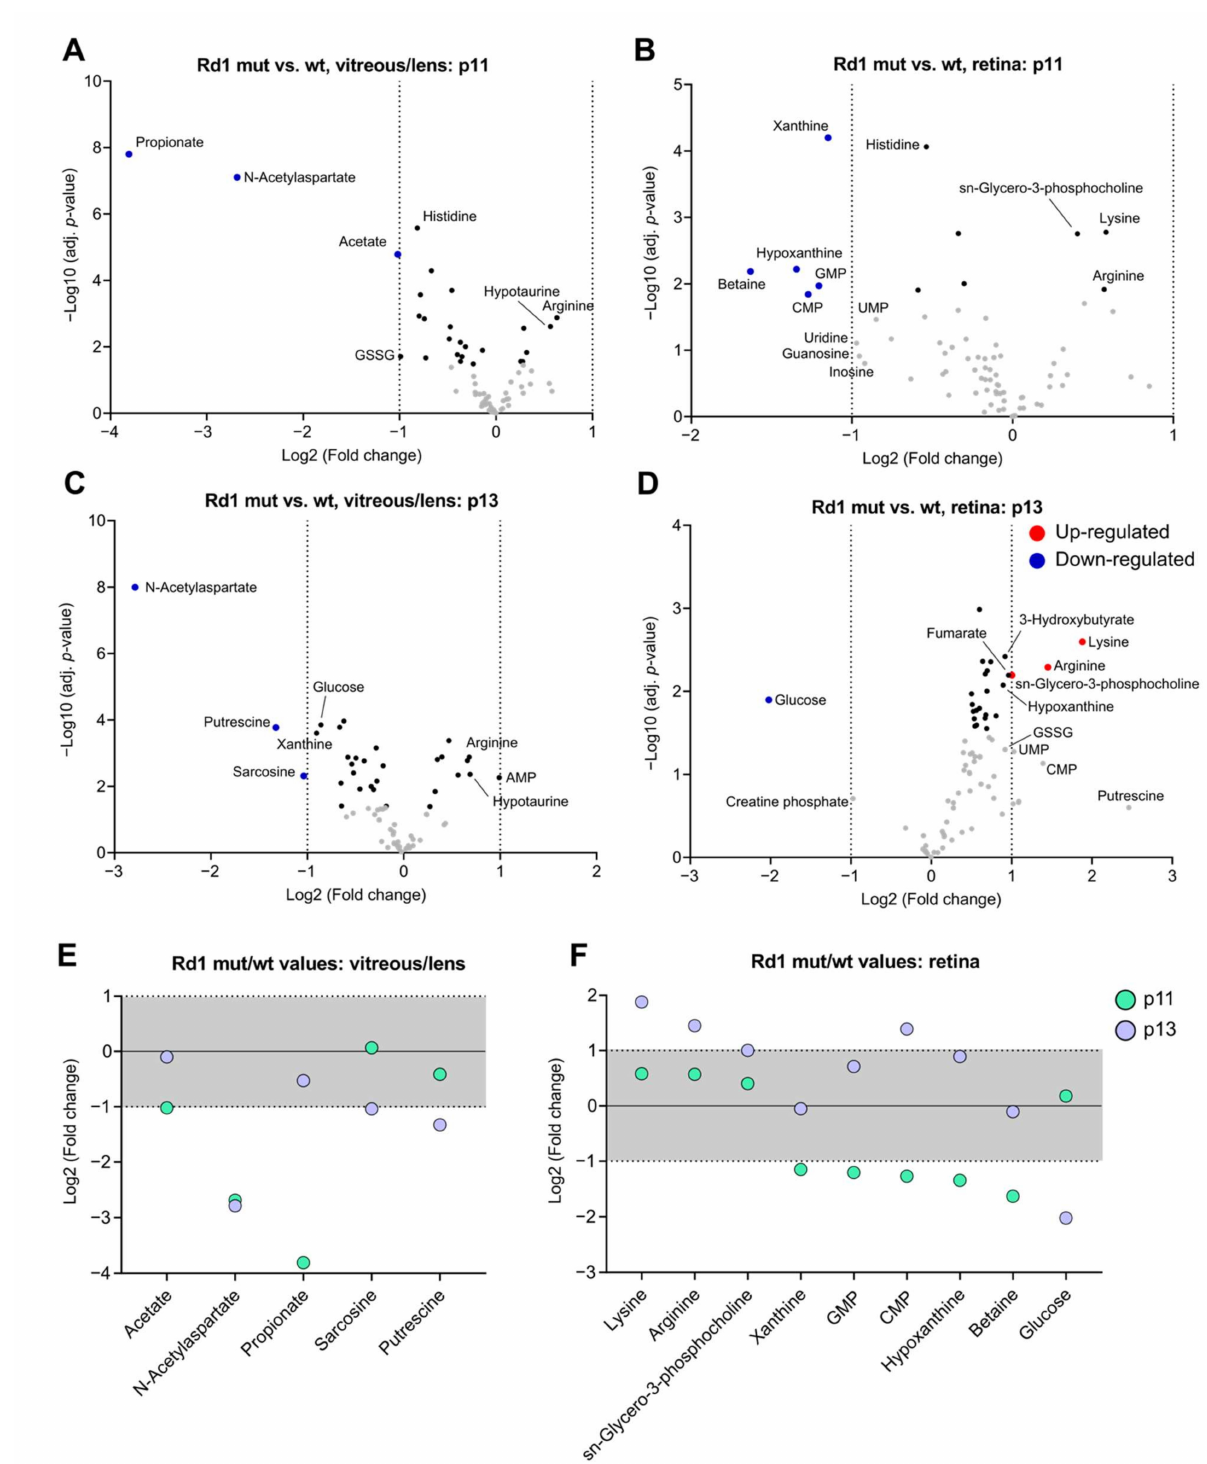
Figure 5. Photoreceptor degeneration results in postnatal stage-dependent deregulation of selected metabolites in vitre- ous/lens and retina. ( A – D ) Volcano plots showing the changes in metabolite concentration between Rd1 mutant and wt in the vitreous/lens ( A , C ) and the retina ( B,D ) at p11 ( A,B ) and p13 ( C , D ). ( E , F ) Summary graphs showing the concentration differences between Rd1 mutant and wt in vitreous/lens ( E ) and retina ( F ) of the significantly deregulated metabolites in ( A – D ). The gray area delimits the cut-off of the Log2 (Fold change). Rd1 wt, vitreous/lens: n = 6 (p11), n = 5 (p13); retina: n = 7 (p11), n = 4 (p13). Rd1 mutant, vitreous/lens: n = 6 (p11), n = 7 (p13); retina: n = 5 (p11), n = 6